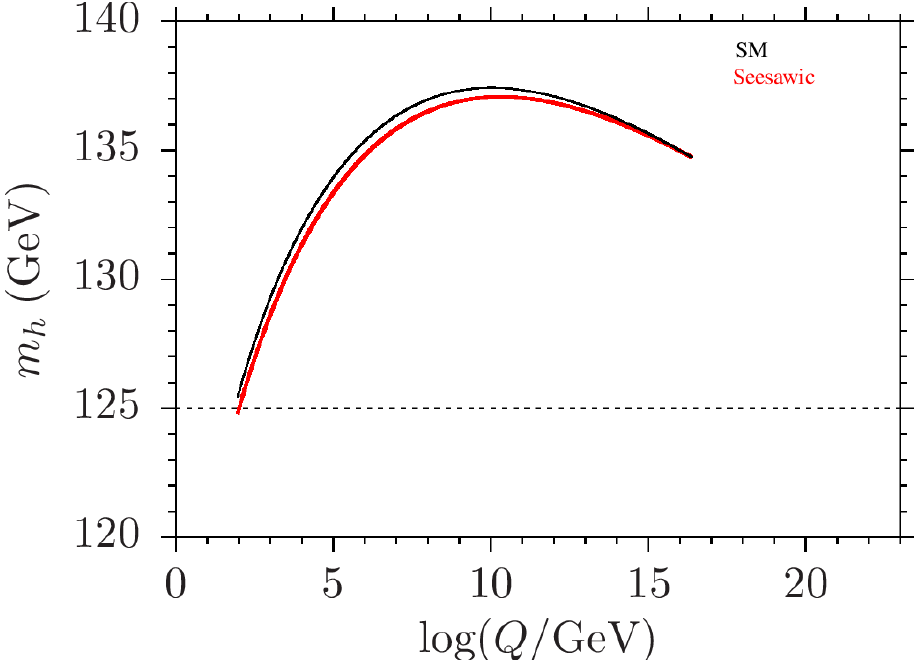
Figure 3. The dependence of the Higgs boson mass on the mass scale Q in the SM (black curve) and in the SM + DS with DS containing a scalar H (cid:48) coupling to the SM as in (44) obeying the naturalness bound in (43). The naturally coupled DS does indeed respect the stability of the electroweak scale. (taken from Reference [38], with the permission of the